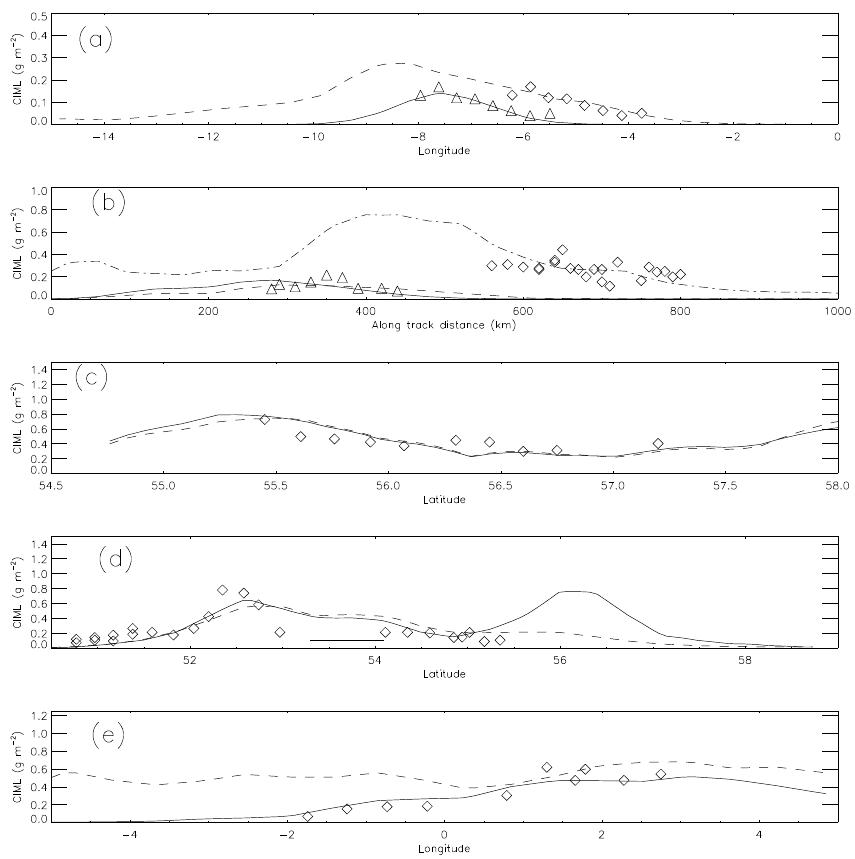
Fig. 9. Comparisons between lidar estimates of CIML and estimates from NAME. (a) Estimates of the CIML from the lidar on 4 May (diamonds) and offset by 1.5 ◦ W (triangles). Estimates of the CIML from NAME, top source (full curve) and uniform emissions (dashed curve). (b) Estimates of the CIML for the 3km layer on the 5 May (diamonds) and the 5km layer (triangles). Estimates of the CIML from NAME using uniform emissions for the ash layer at 3km (dot-dashed line), for the layer at 5km for top source (solid line), for the uniform emissions (dashed line). The NAME results are scaled to fit the observations. (c) Lidar estimates of the CIML on the 14 (diamonds). Estimates of the CIML from NAME for top source (solid line) and uniform emissions (dashed line). (d) as (c) but for 16 May. (e) as (c) but for 17 May. good agreement with the lidar estimates, with both the lidar and NAME column loadings being small to the west of 2 ◦